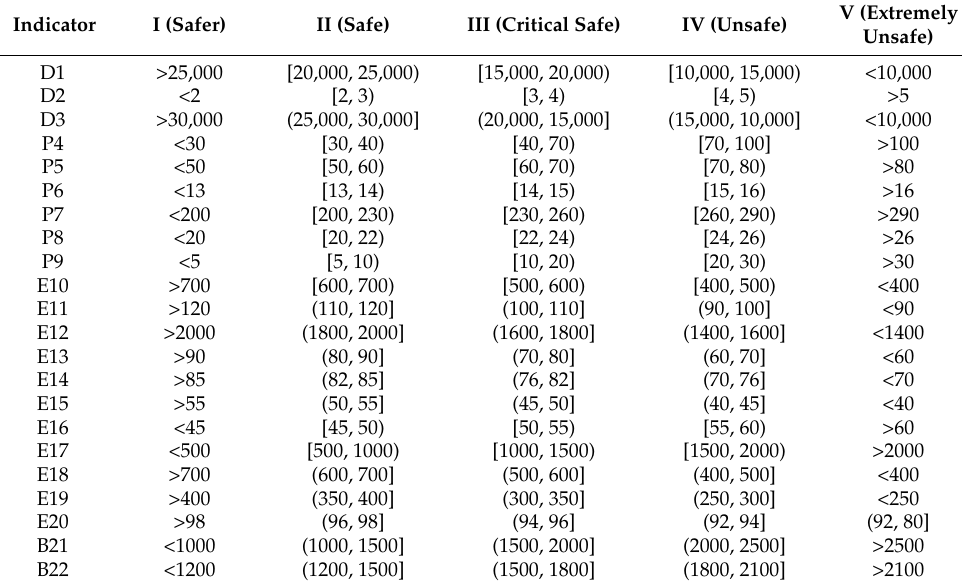
Table 2. Urban water security evaluation